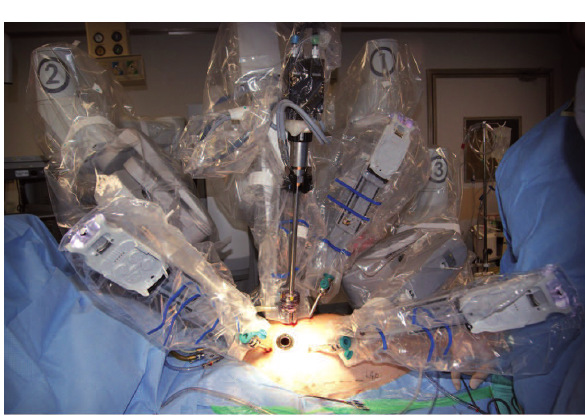
Fig. 2 - Aspecto externo do campo operatório: sistema robótico DaVinci® conectado aos trocartes